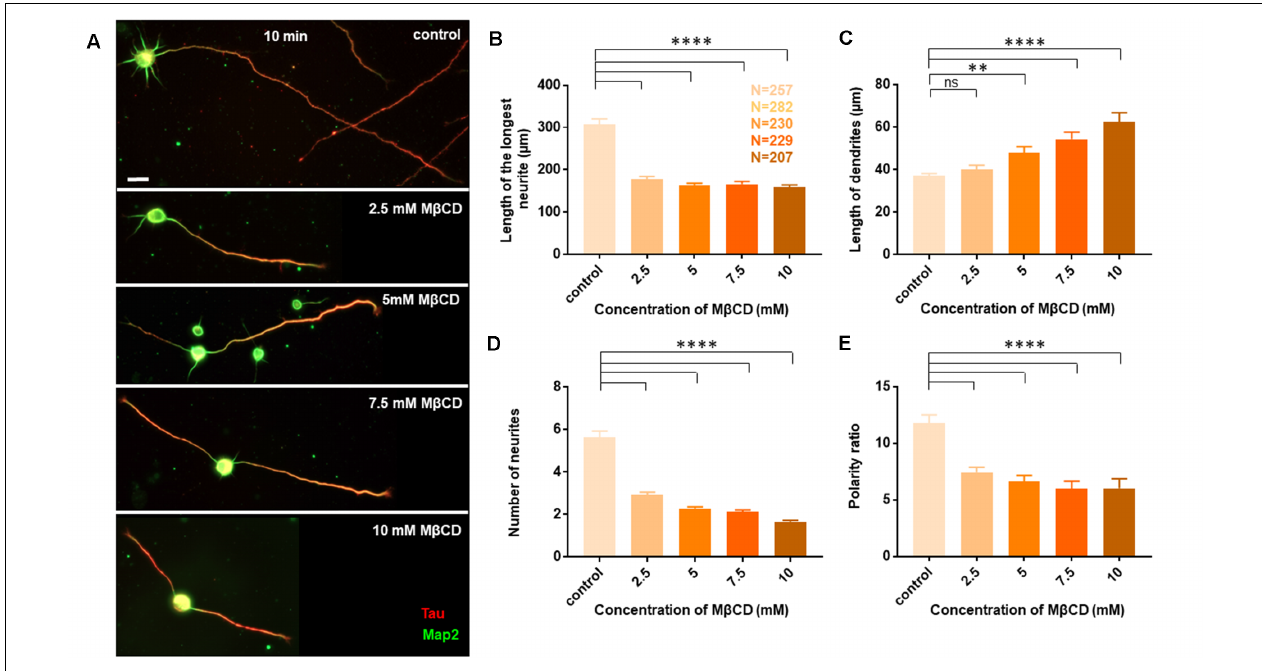
FIGURE 2 | Neurons exhibit opposing effects for axonal and dendritic growth upon transient perturbation of membrane cholesterol. Neurons at DIV1 were transiently treated with varying concentrations of M β CD for 10 min to sequester cholesterol. The cells were labeled with Tau (red) and Map2 (green) and imaged at DIV3. (A) A gallery of control and cells treated with varying concentrations of M β CD for 10 min is presented. (B–E) Represents the length of the longest neurite (B) , length of dendrites (C) , number of neurites in each cell (D) , and the neuronal polarity ratio (E) . Cholesterol sequestered neurons displayed a significant defect in axonal growth but complemented dendritic growth. N denotes the number of cells from five independent cultures. One-way Anova was performed to test the significance of the difference between the means. ∗∗∗∗ p < 0.0001, ∗∗ p < 0.01 and ns denotes non-significant. Scale bar indicates 20 µ m.